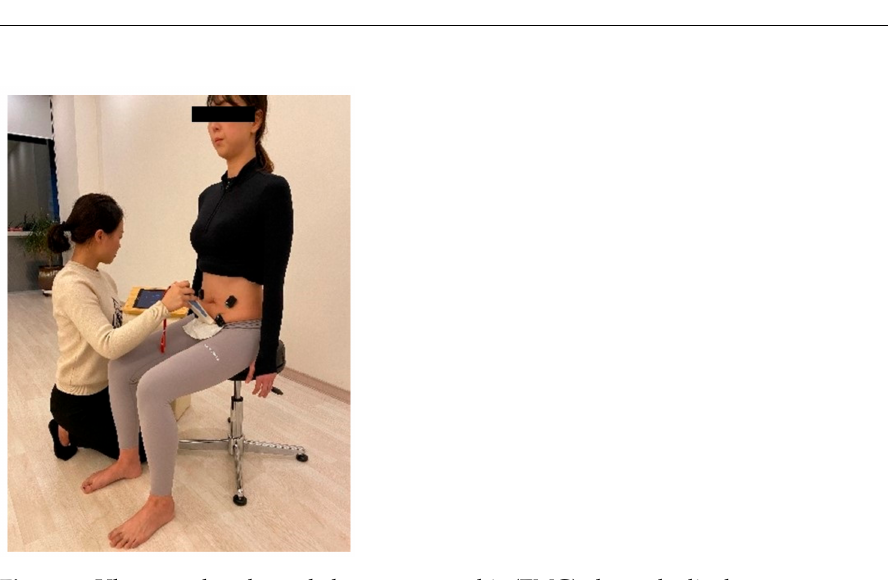
Figure 2. Ultrasound probe and electromyographic (EMG) electrode